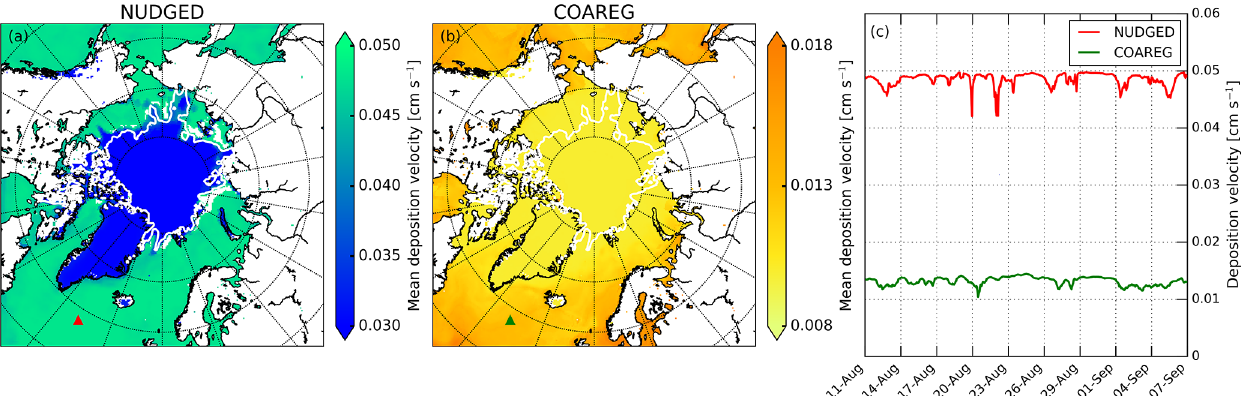
Figure 2. Spatial distribution of the mean simulated O 3 deposition velocity to snow/ice and oceans (cms − 1 ) for the (a) NUDGED and (b) COAREG simulations and (c) temporal variation in O 3 deposition velocity (cms − 1 ) for the NUDGED (red) and COAREG (green) simulations. The red and green markers in (a) and (b) indicate the location of the time series shown in (c) . To give an indication of the sea ice extent, the white contours show the sea ice fraction of 0.5 at the start of the simulation. Table 1. Mean simulated O 3 deposition velocity ( ± standard deviation) (cms − 1 ) and total simulated deposition budget (Tg O 3 yr − 1 ) for the NUDGED and COAREG runs to water, snow/ice and land each representing 37%, 15% and 48% of the total surface area, respectively. The standard deviation gives an indication of the spatiotemporal variability in simulated O 3 deposition velocities. Water (37%) Snow/ice (15%) Land (48%) Total (100%) Deposition velocity ( ± SD) (cms − 1 NUDGED